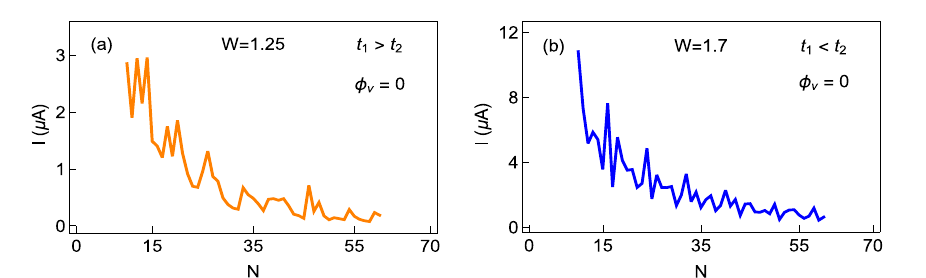
Figure 11. Absolute current as a function of the ring size in the half-filled limit for the ( a ) non-staggered and ( b ) staggered AAH SSH